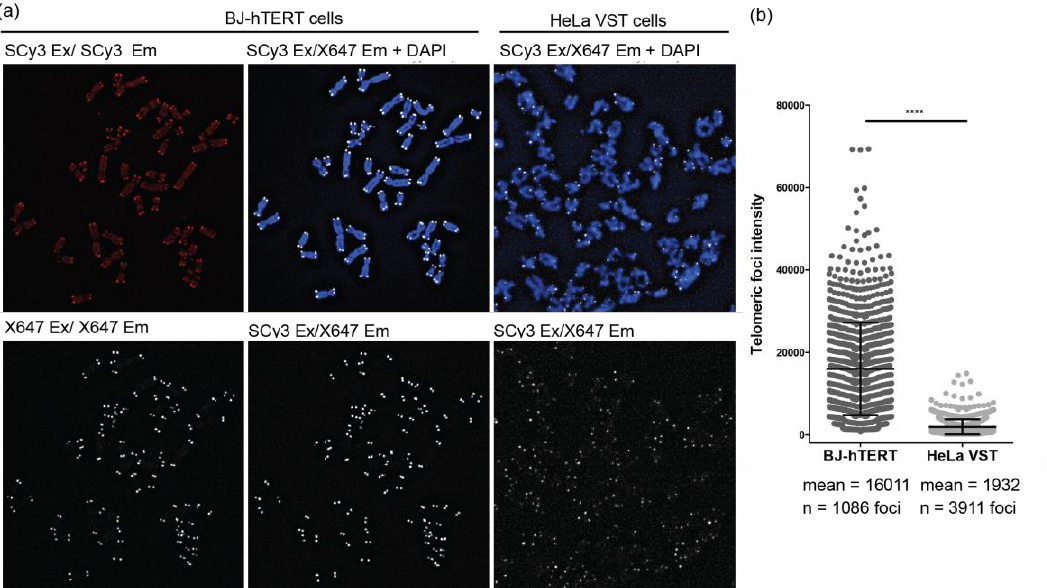
Figure 6. Measurement of telomere length by qFISH on metaphase chromosomes using FRET pair miniprobes. ( a ) Metaphase chromosome spreads from BJ-hTERT or HeLa VST cells were stained with a mix of the SCy3-γPNA and X647-γPNA probes (10:1 ratio) by qFISH in the absence of washing. Images were captured using filters for SCy3 excitation and emission (red), X647 excitation and emission (white) or SCy3 excitation and X647 emission (white, FRET channel). Look up tables (LUT) equal 1000 (BJ-hTERT) or 500 (HeLa VST). ( b ) Fluorescence signal intensity was measured for each telomeric foci in the FRET channel. Data from 5 metaphases for each cell line from 2–3 independent stainings are shown. Mean and SEM from total foci are shown. **** p < 0.0001, unpaired t -test.